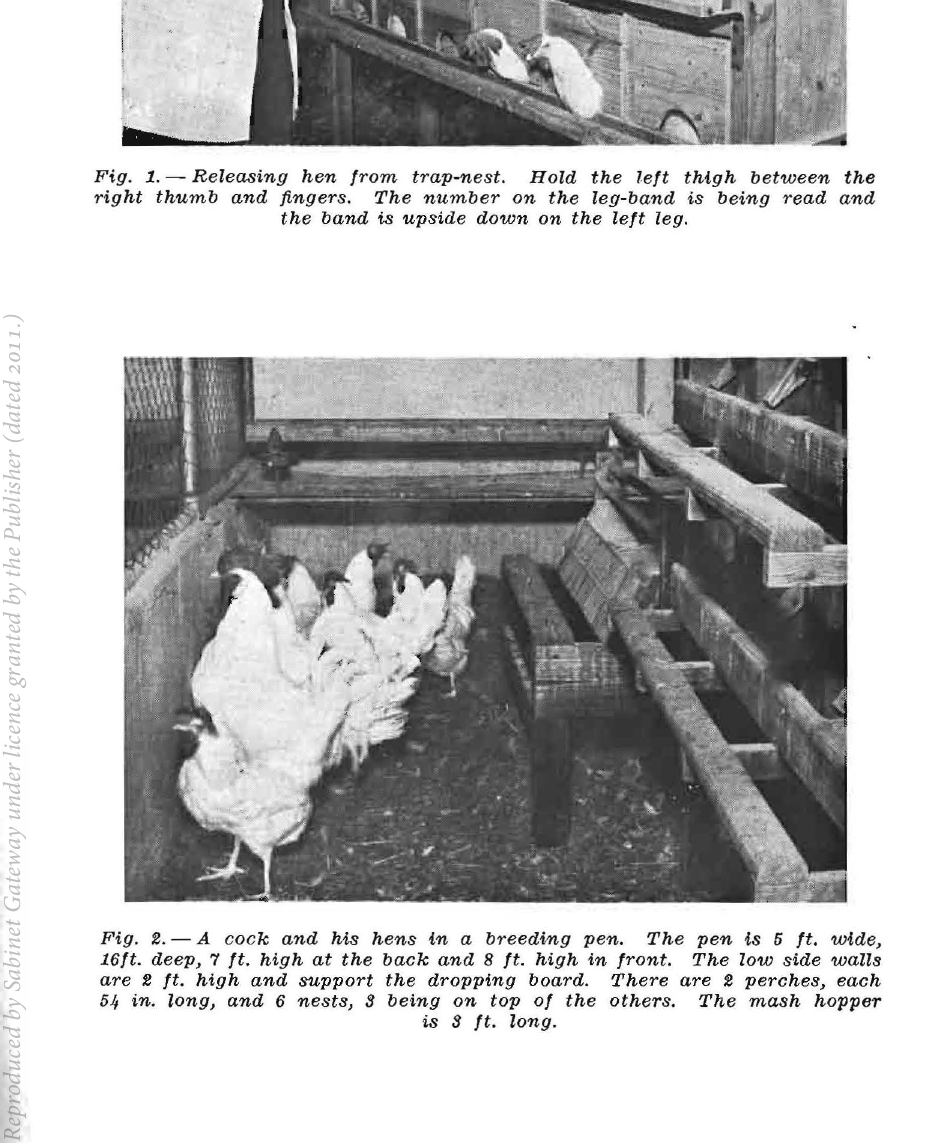
Fig. 2. - A cock and his hens in a breeding pen. The pen is 5 ft. wide, 16ft. deep, '"I ft. high at the back and 8 ft. high in front. The low side walls are 2 ft. high and support the dropping board. There are 2 perches, each 54 in. long, and 6 nests, 3 being on top of the others. The mash hopper is 3 ft.